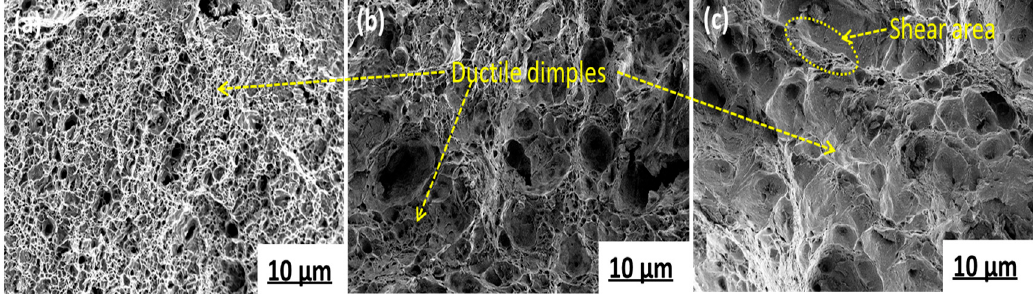
Figure 13. Tensile fracture morphology of test steel. ( a ) 650 °C; ( b ) 700 °C; ( c ) 750 °C.